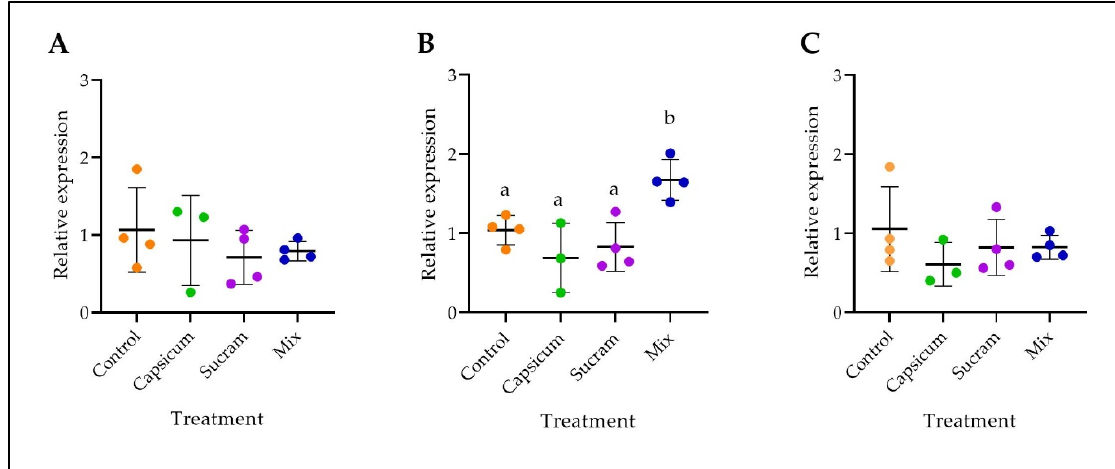
Figure 6. Relative gene expression of the taste receptor family 1 member 2 (( A ); T1R2; p = 0.193), taste receptor family 1 member 3 (( B ); T1R3; p = 0.005) and sodium-dependent glucose transporter isoform 1 (( C ); SGLT1; p = 0.378) in the proximal jejunum of sheep fed an unflavoured diet (control) or diet flavoured with sucram, capsicum or both (mix). Means ± standard error with different letters (a, b) differ significantly ( p ≤ 0.05).